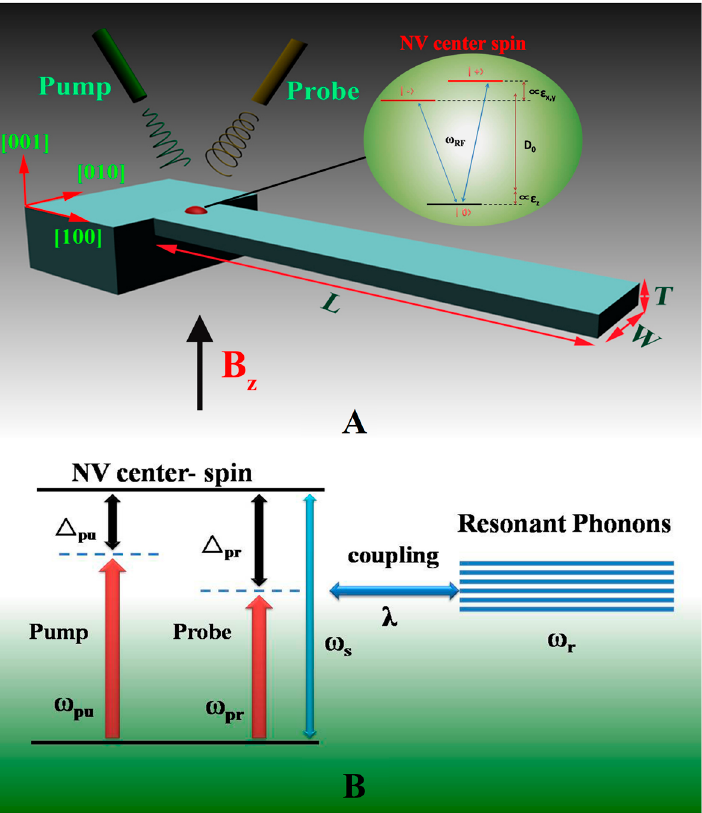
Figure 7. ( A ) Schematic diagram of the hybrid spin microcantilever system in the presence of a strong pump field and a weak probe field; ( B ) the energy level diagram of the coupling between the NV center spin and the microcantilever [57].